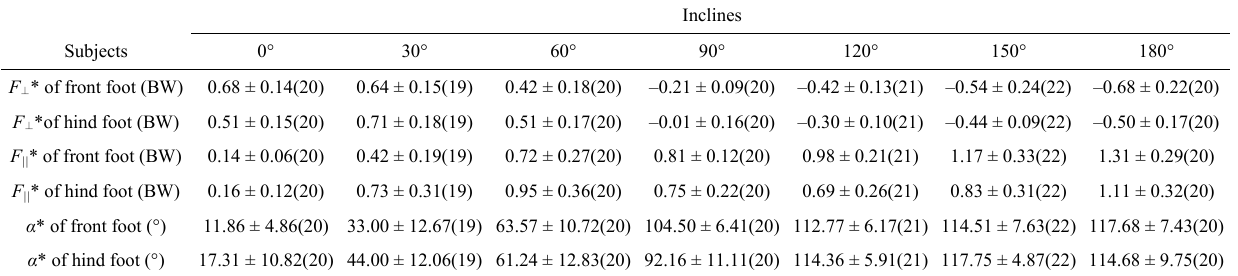
Fig. 4 Critical angle of the resultant force vector and the critical forces corresponding to the critical angle. (a) Box and whisker plots of the critical angle of the resultant force vector of the feet as related to the incline. (b) The results of hierarchical clustering analysis of the  * on different inclines. In (b), the horizontal coordinates indicate the data of the  * of the front and hind feet from 0° incline to 180° incline. For example, the F-0° means the data of  * of the front foot on 0° incline; the H-0° means the data of  * of the hind foot on 0° incline. Table 1 Mean of forces and angles of front and hind feet of gecko at different